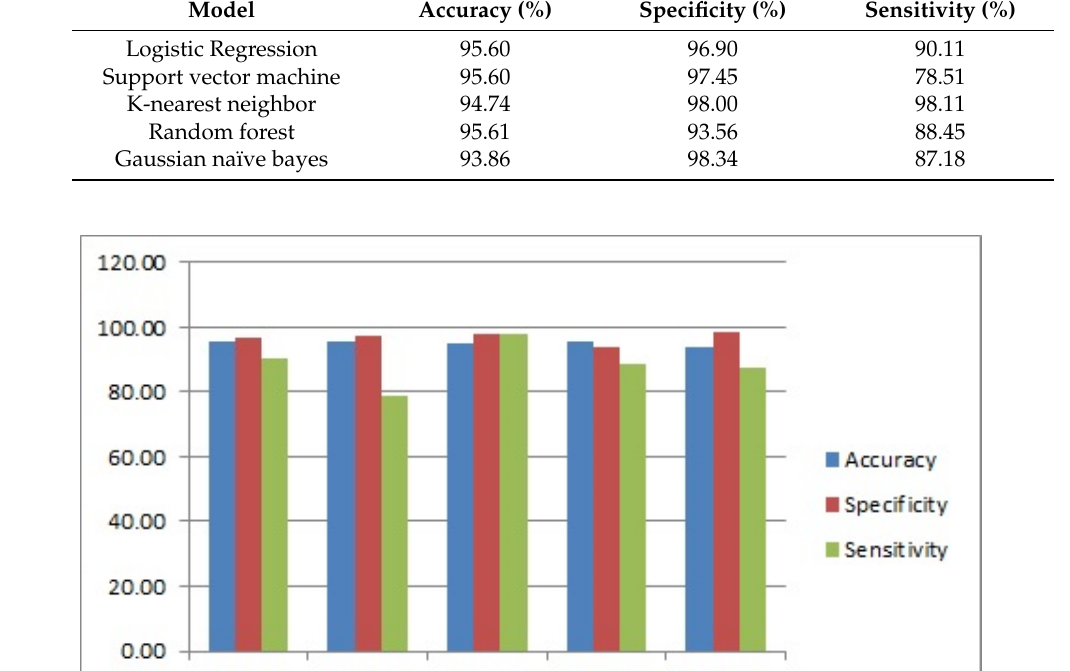
Table 4. Performance evaluation of classification models with full features against that of the models with selected fittest features.